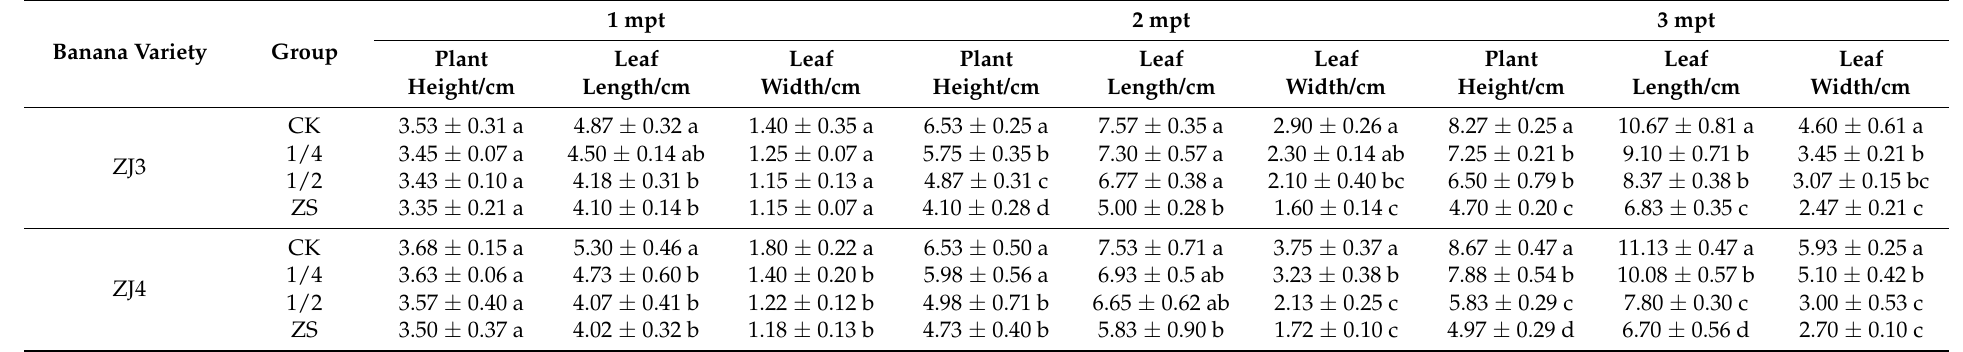
Table 2. Effects of bamboo fungus on the growth indexes of ‘Zhongjiao No.3’ (ZJ3) and ‘Zhongjiao No.4’ (ZJ4) banana seedlings. CK: seedlings grown in nutrient soil; 1/4: seedlings grown in nutrient soil containing 1/4 bamboo fungus culture substrates; 1/2: seedlings grown in nutrient soil containing 1/2 bamboo fungus culture substrates; ZS: seedlings grown in bamboo fungus culture substrates. The different letters within the same column represent significant difference among samples at 0.05 level.